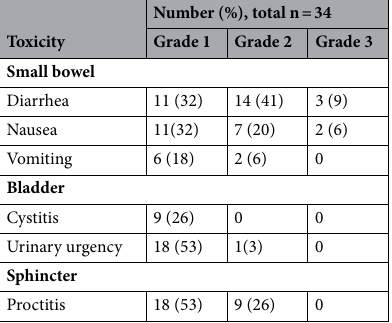
Table 2. Maximum acute bladder, small bowel and sphincter adverse effects during 3D-conformal chemoradiotherapy. Toxicities were classified according to Common Terminology Criteria for Adverse Events version 4.03.